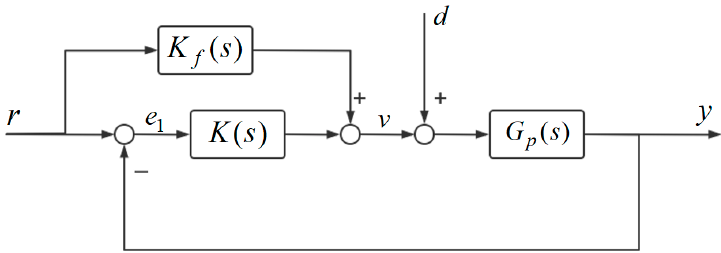
Figure 6. 1DOF PID control system 2